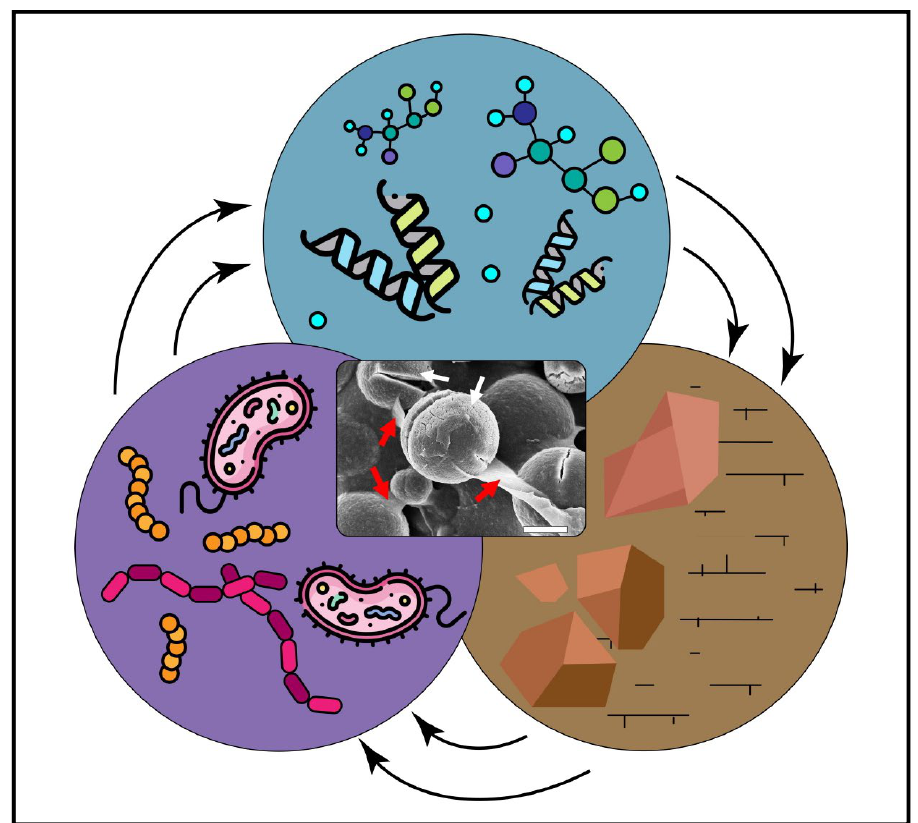
Figure 1. Circle diagram showing the biogenic formation of carbonate minerals. The compendium of minerals found in the natural environments (brown circle), microorganisms capable of forming carbonate minerals (purple circle) and the biochemistry of the process at a nano- and micrometric scale involving the biomacromolecules produced by the microorganisms that interfere in the nucleation and mineral growth process (green circle), resulting in the biogenic creation of minerals associated to biological processes (center). The SEM image in the center represents rounded spherical crystals made of Ca-Mg carbonate (white arrows) bonded together by EPS (red arrows). Scale bar: 10 µm.